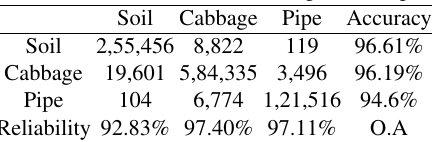
Table 3: Confusion Matrix using RMSProp